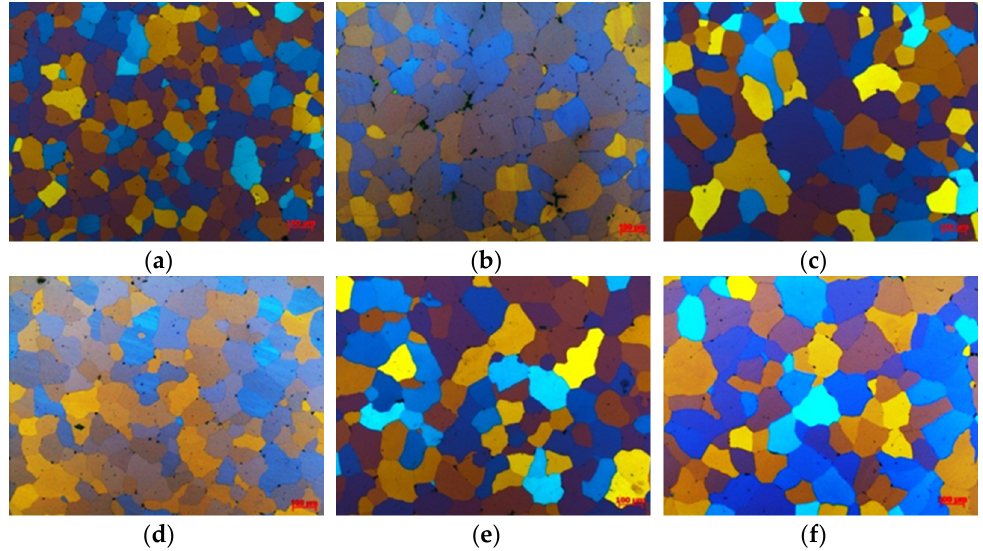
Figure 4. Grain structure of 7050 ingot: ( a ) Al-5Ti-0.2B surface, ( b ) Al-5Ti-0.2B 1/4 thickness, ( c ) Al-5Ti-0.2B 1/2 thickness, ( d ) Al-3Ti-0.15C surface, ( e ) Al-3Ti-0.15C 1/4 thickness, and ( f ) Al-3Ti-0.15C 1/2 thickness.